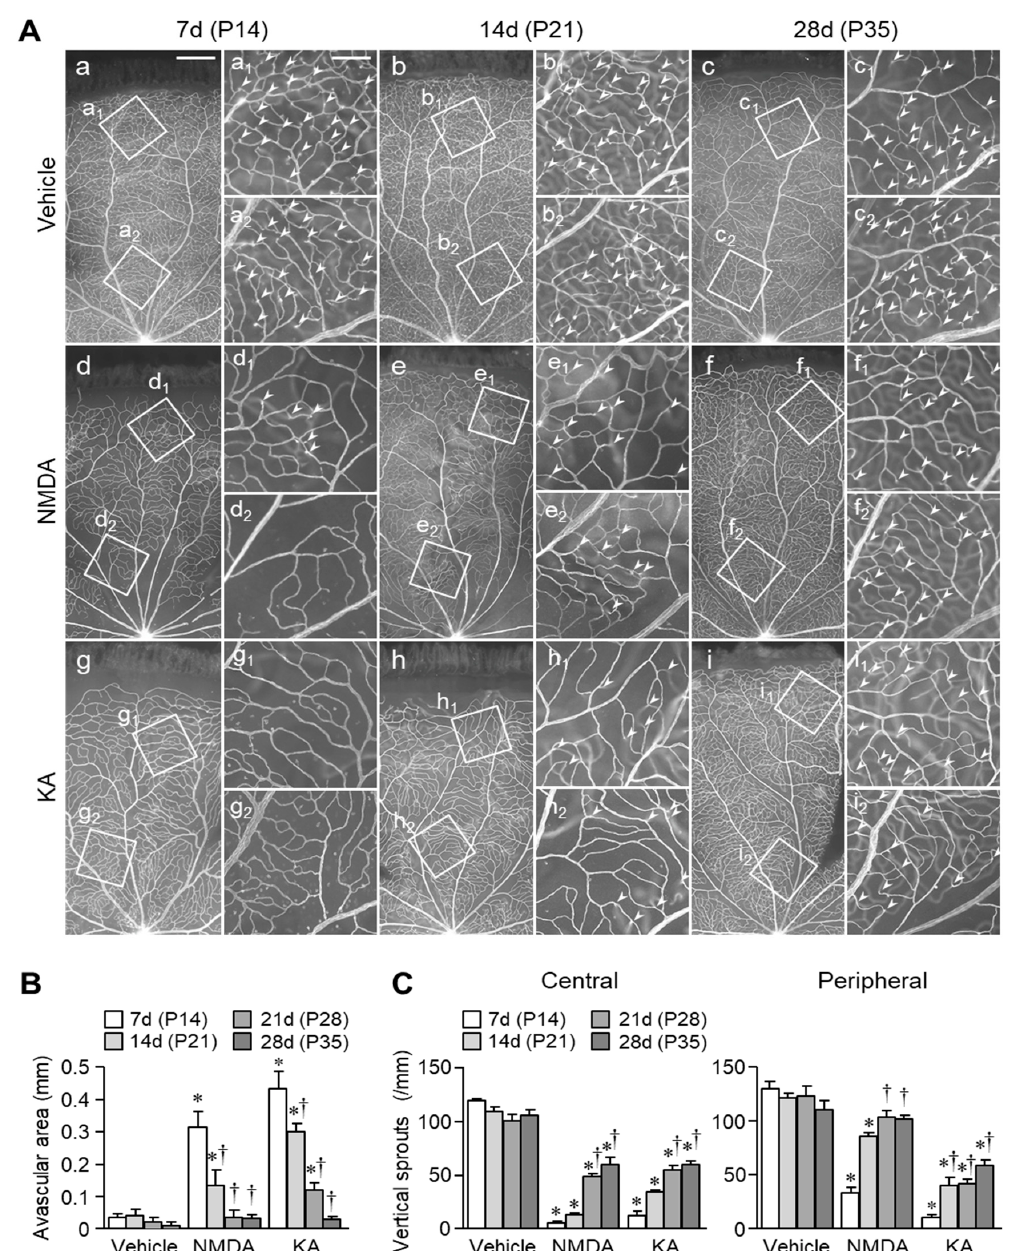
Figure 2. Changes in retinal vasculature in rats intravitreally injected with NMDA or KA. ( A ) Fluorescence photomicrographs of retinal whole-mounts stained with an endothelial cell marker (RECA) obtained 7 (P14), 14 (P21), and 28 days (P35) following intravitreal injection of vehicle, NMDA (200 nmol) or KA (20 nmol) on P7. Higher-magnification images of the insets are shown in the panels Aa 1 –i 1 and Aa 2 –i 2 . Arrowheads indicate vertical sprouts. Scale bars = 500 µ m in a (applies to b–i) and 150 µ m in a 1 (applies to b 1 –i 1 and a 2 –i 2 ). ( B , C ) Quantification of the distance from the developing edge of the vascular bed to the peripheral edge of the retina ( B ) and the number of vertical sprouts in central and peripheral retinal areas ( C ). * p < 0.05 vs. the corresponding age-matched control value (vehicle). † p < 0.05 vs. the corresponding seven days after the injection. n =